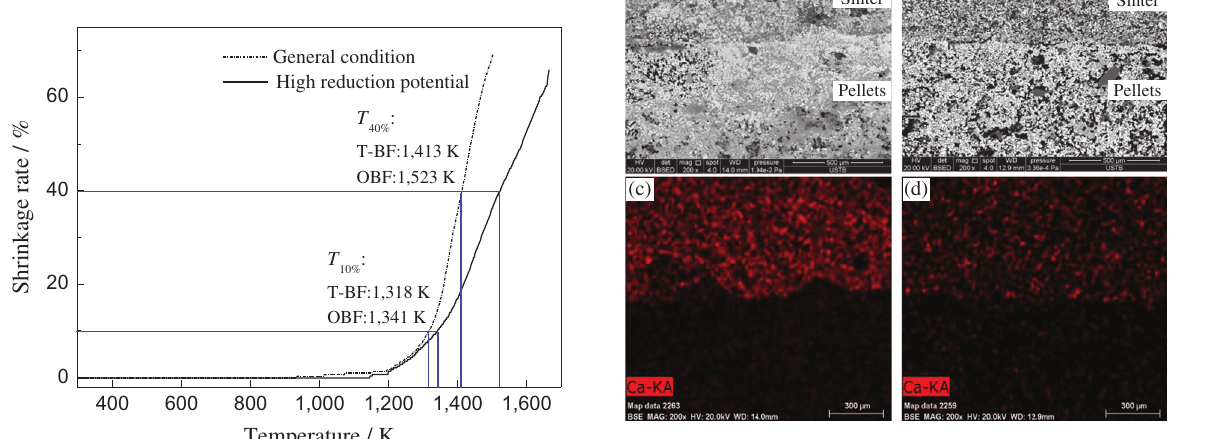
Figure 13: The microstructure in the interface of pellet and sinter at 10% shrinkage rate. (a) General condition 10%; (b) high reduction potential 10%; (c) and (d)